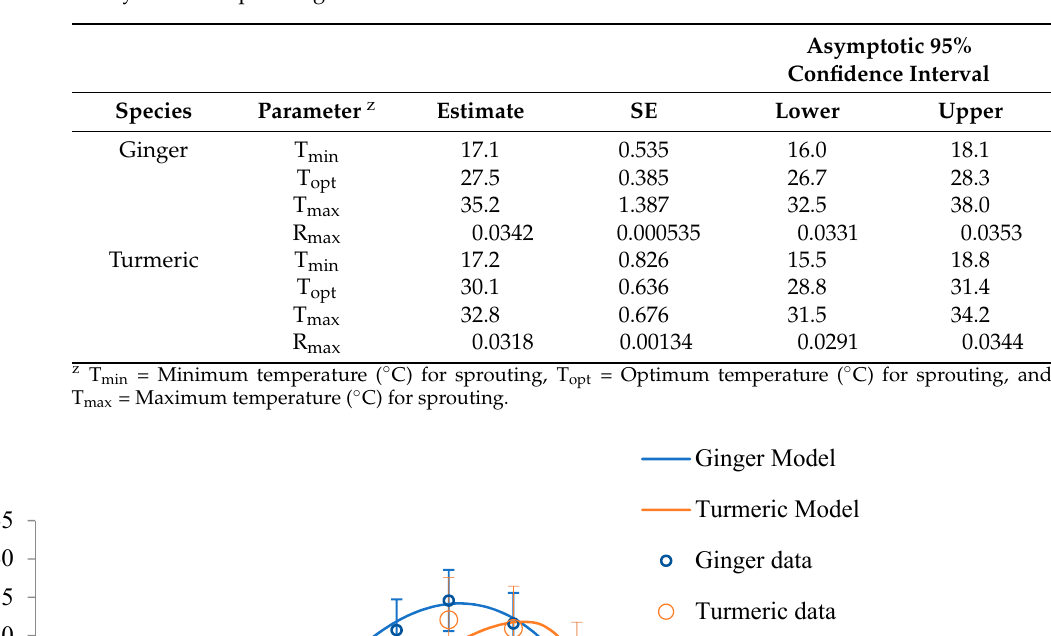
Table 1. Nonlinear regression results from fitting the Landsberg function (Equation (1)) to the inverse of days to 5-cm sprouting for the calibration dataset.